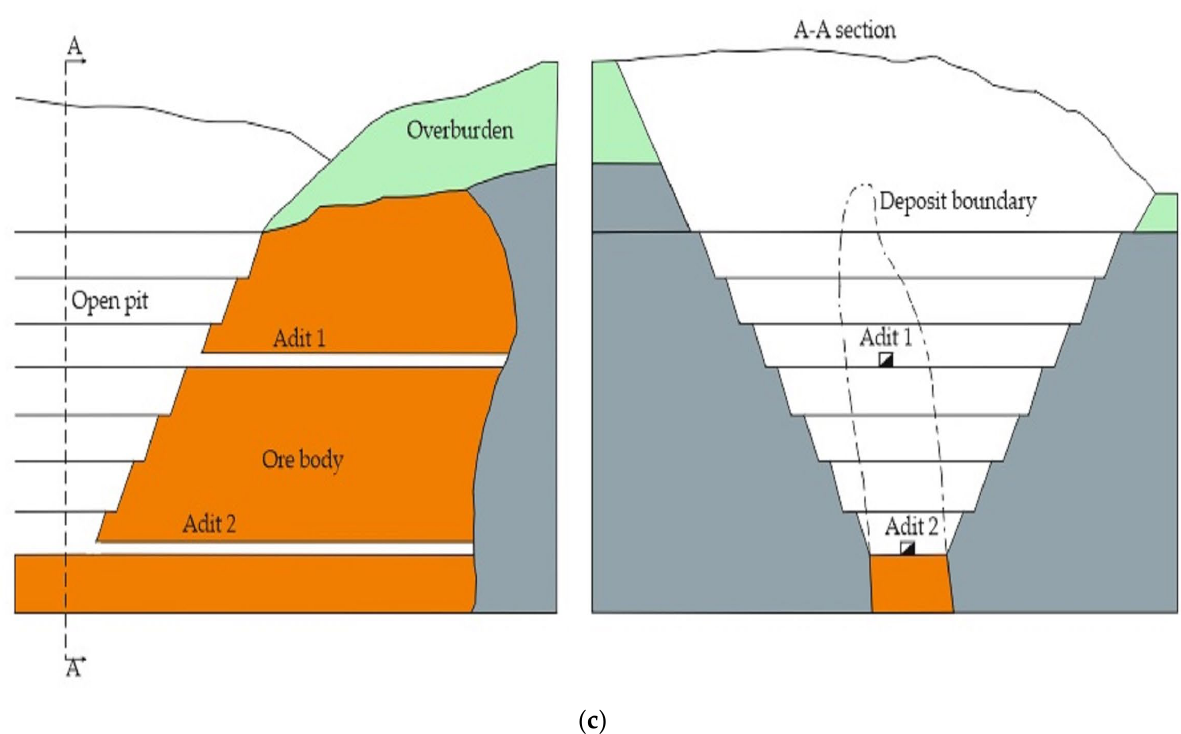
Figure 3. Access by means of adit: ( a ) Perpendicular to the strike; ( b ) Several adits; ( c ) From open pit